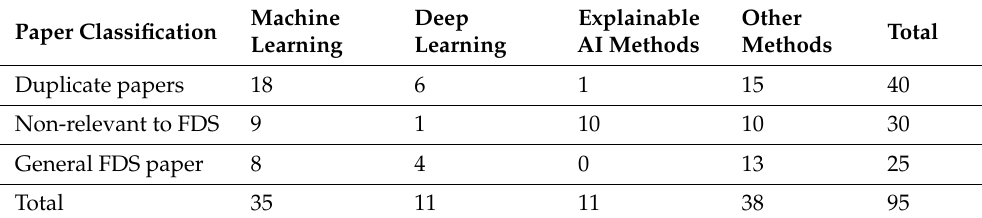
Table 2. Literature